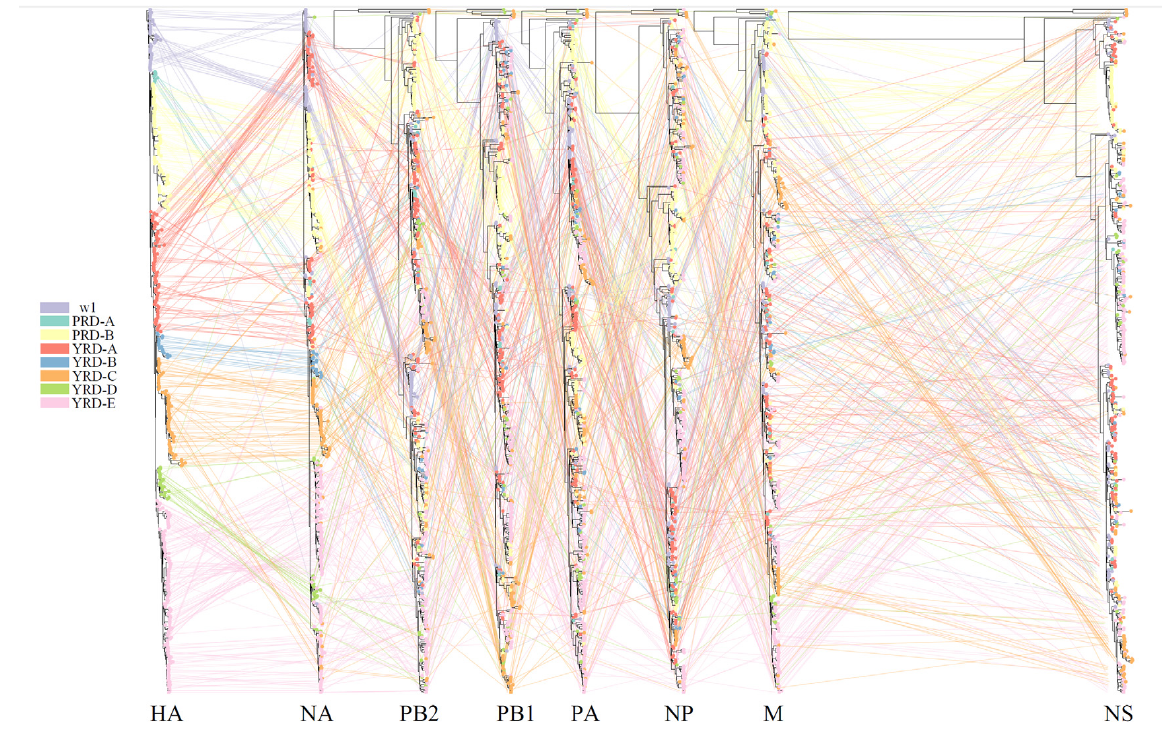
Figure 5. Phylogenetic incongruence analysis. MCC trees for the HA segment and all internal genes NA, PB2, PB1, PA, NP, and M from equivalent strains connect across the trees. Tips and connecting lines are colored according to the HA clusters.